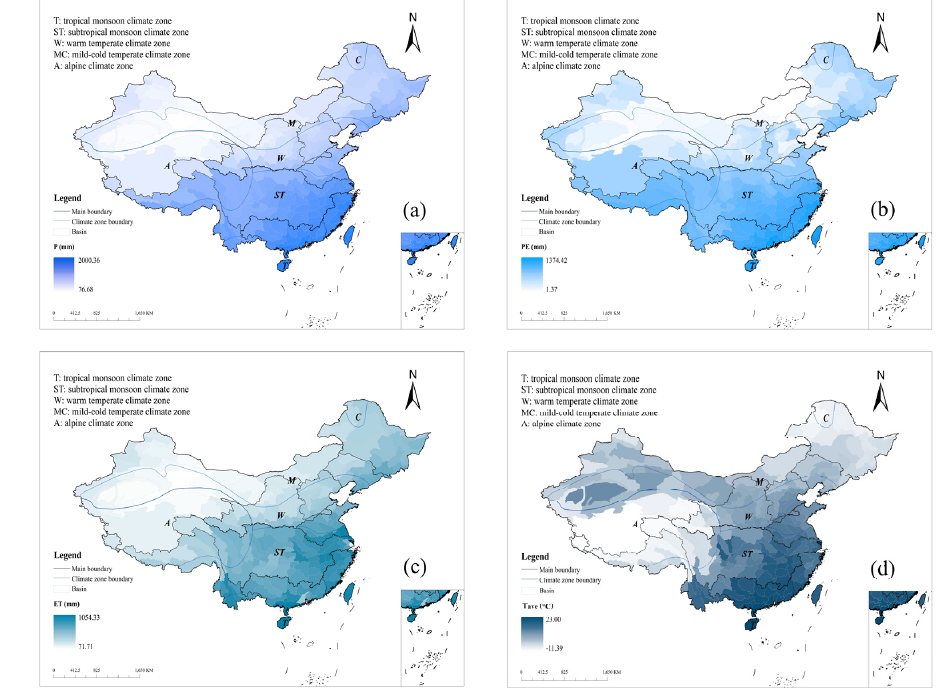
Figure A1. The spatial distributions of long-term ( a ) P ; ( b ) PE ; ( c ) ET ; and ( d ) T ave .